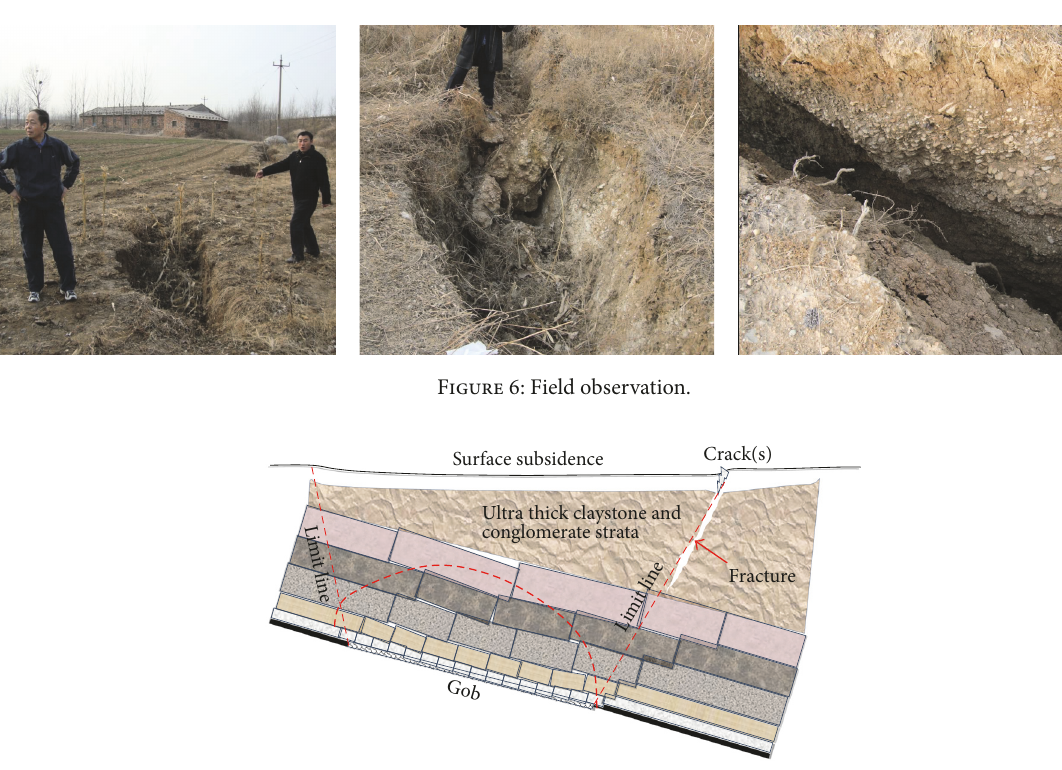
Figure 7: Schematic of discontinuous or stepped subsidence under the influence of ultrathick conglomerate